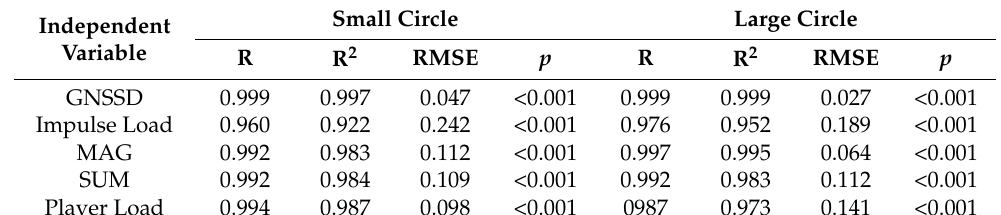
Table 4. Summary of linear regression models.